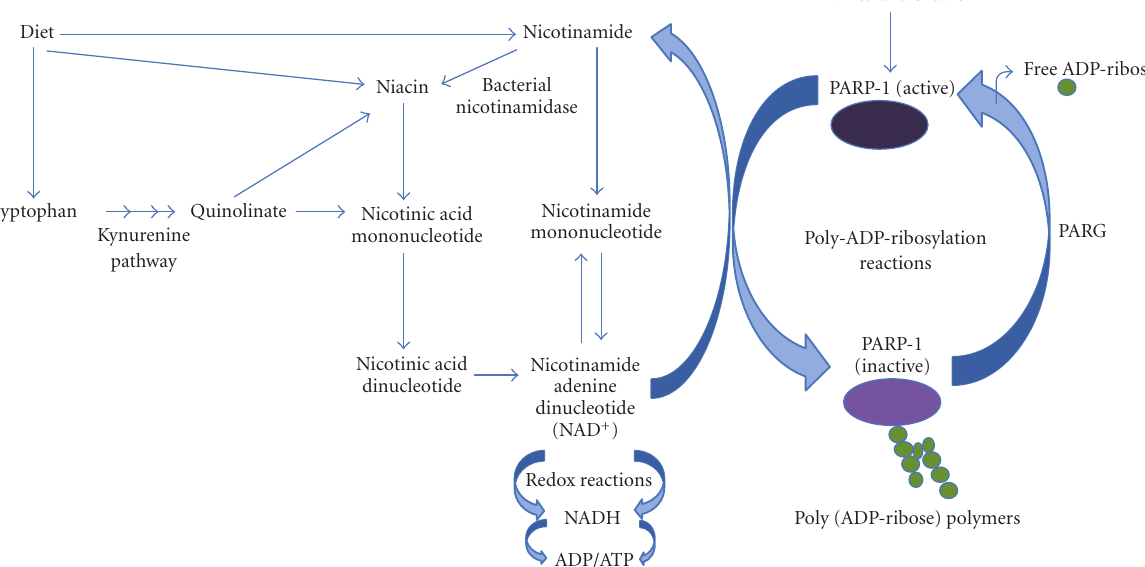
Figure 2: The simplified pathways for nicotinamide, niacin, NAD + , and PARP-1 metabolism. Dietary nicotinamide, niacin, and tryptophan are precursors for the synthesis of NAD + , essential in ATP production and PARP-1 activation. Nicotinamide can be converted to niacin by bacterial nicotinamidase in the intestinal lumen. PARP-1 is activated by DNA strand breaks, cleaving NAD + into nicotinamide and ADP-ribose. Poly(ADP-ribose) glycohydrolase (PARG) reactivates PARP-1 by removing poly(ADP-ribose)polymers, allowing for continuous NAD + utilization. Figure is adapted from Jacobson et al., in 1995 [6] and Meyer-Ficca et al., in 2004